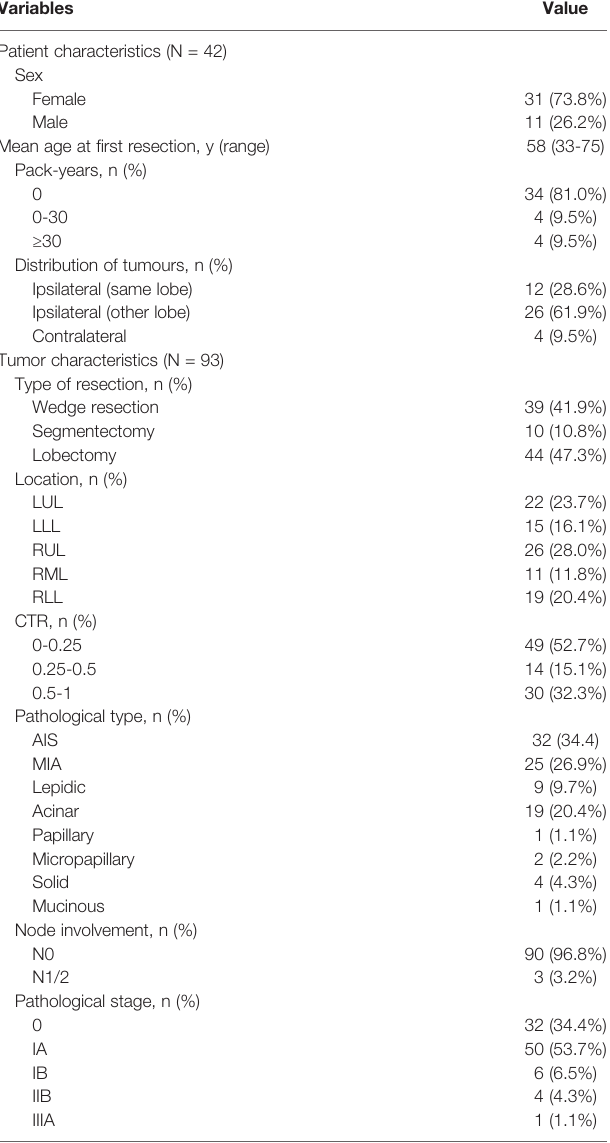
TABLE 1 | Clinical, pathological and imaging characteristics of 42 sMPLA cases.